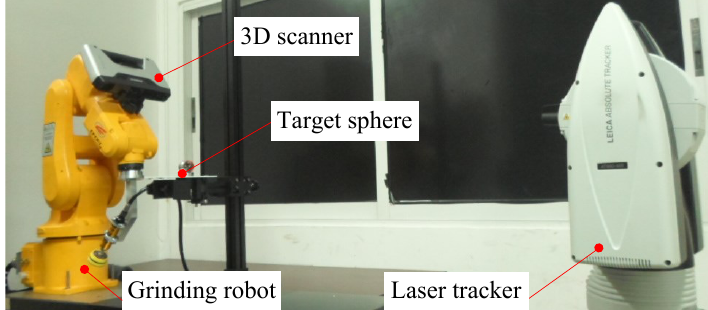
Figure 4. The calibration experiment platform for the vision measurement system of the grinding